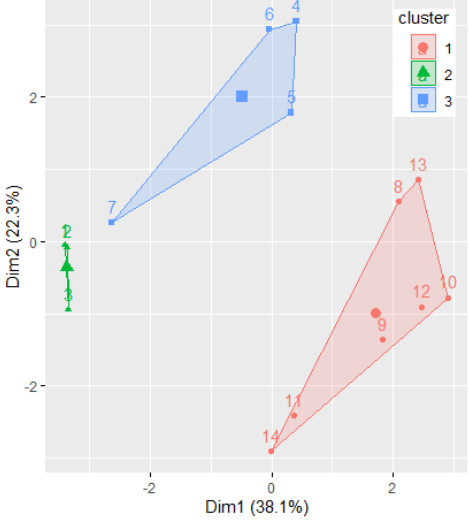
Figure 7. The results of grouping the molecules by k-means algorithm. The Ox and Oy axes are the first two PCs.